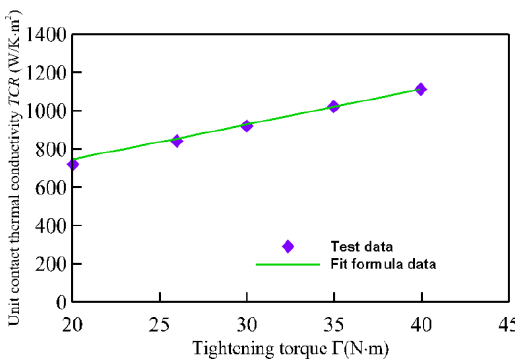
Figure 16. Comparison of unit contact thermal conductivity between test data and prediction modeling for typical flange mounting edge.